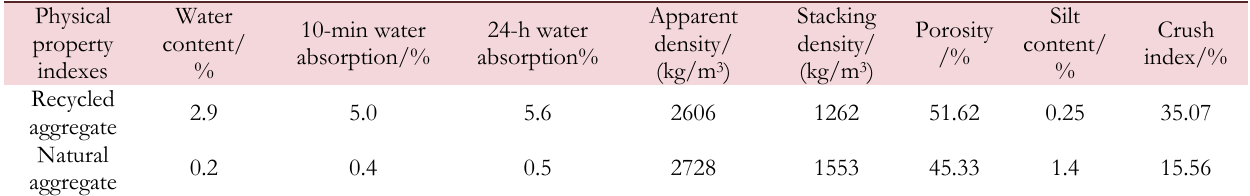
Table 3: The physical properties of the natural aggregate and recycled